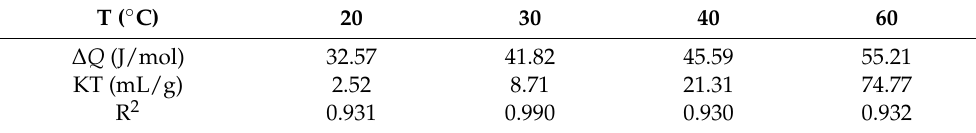
Table 2. Temkin parameters estimated by fitting sinigrin adsorption experimental adsorption data at various temperatures in the range 20–60 ◦